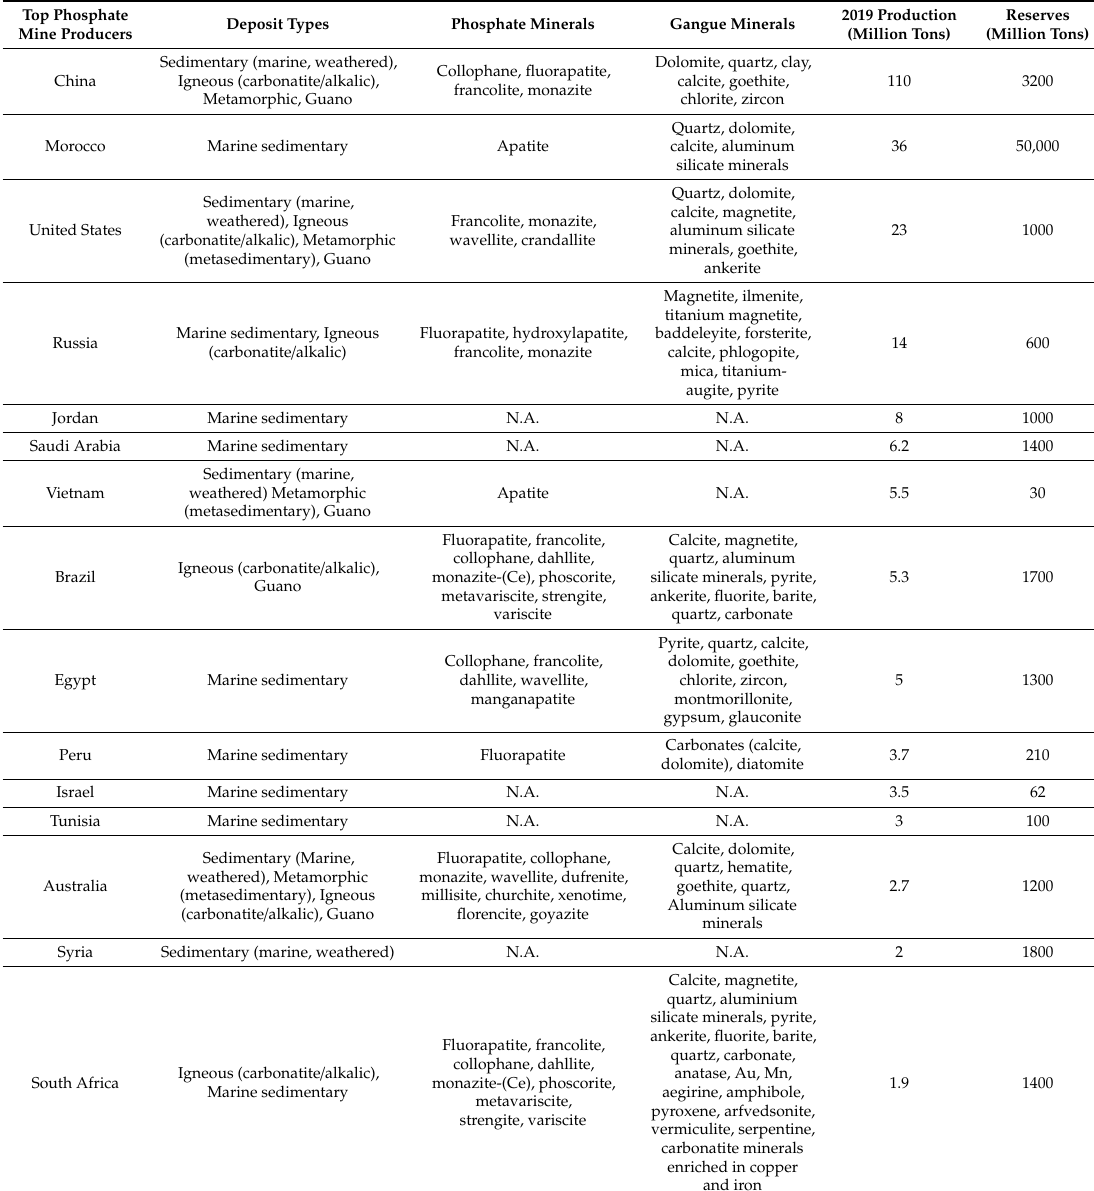
Table 1. Leading phosphate producers